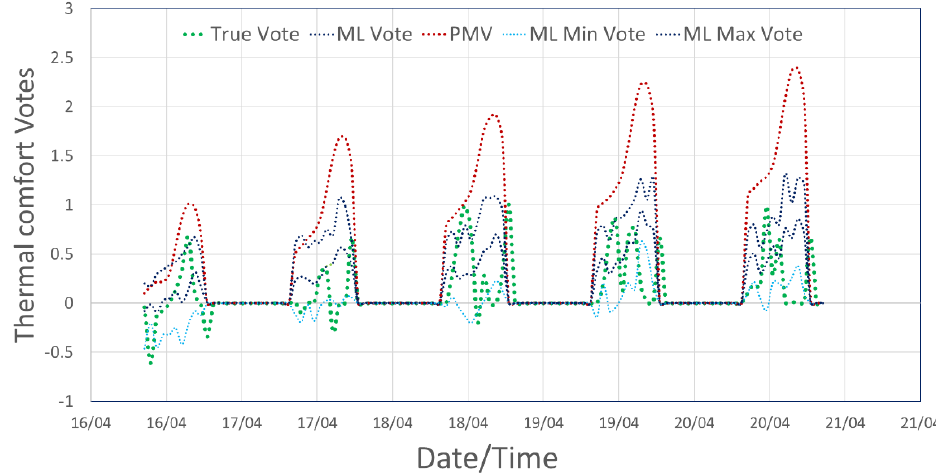
Figure 18. Comparison of the votes from the occupants with the ML model predictions and the normative PMV approach.